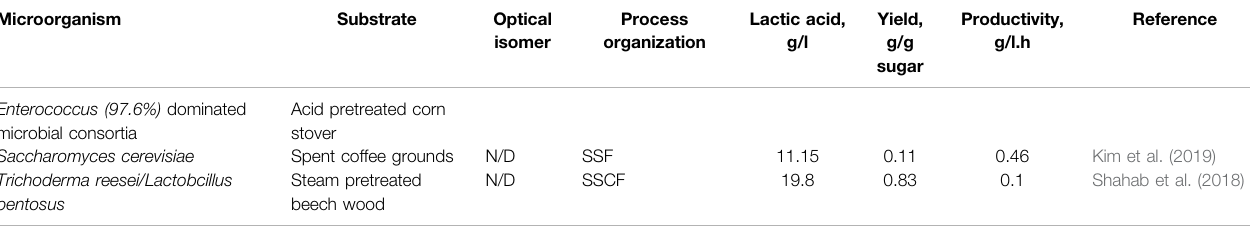
TABLE 4 | ( Continued ) Microorganisms, substrates, and lactic acid yield and productivity from different